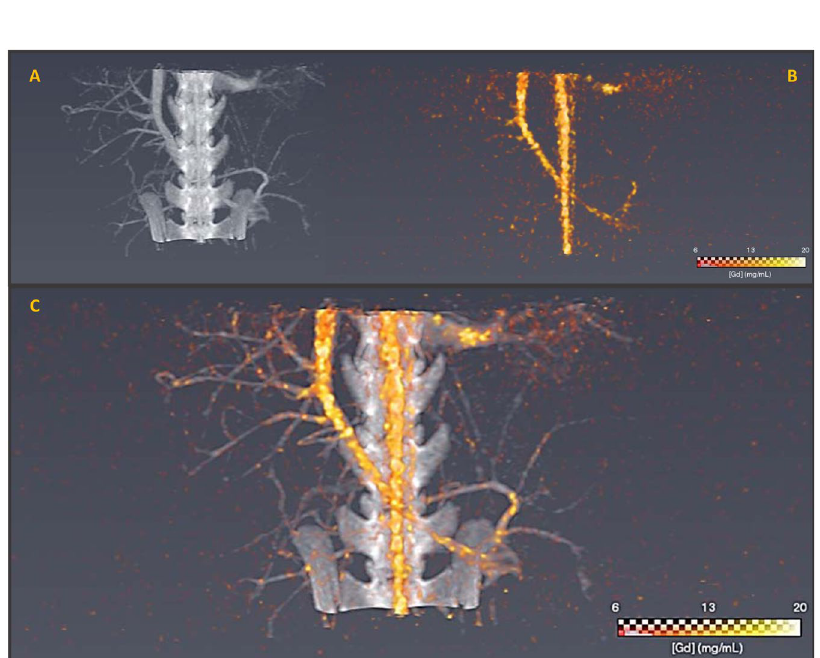
Figure 7. SPCCT conventional HU image ( A ) SPCCT gadolinium K-edge image ( B ) and overlay between SPCCT conventional HU and Gd K-edge images ( C ) of abdomen of rat after GdF 3 injection (5 min). Both images are reconstructed on an isotropic voxel grid at 250 µ m * 250 µ m * 250 µ